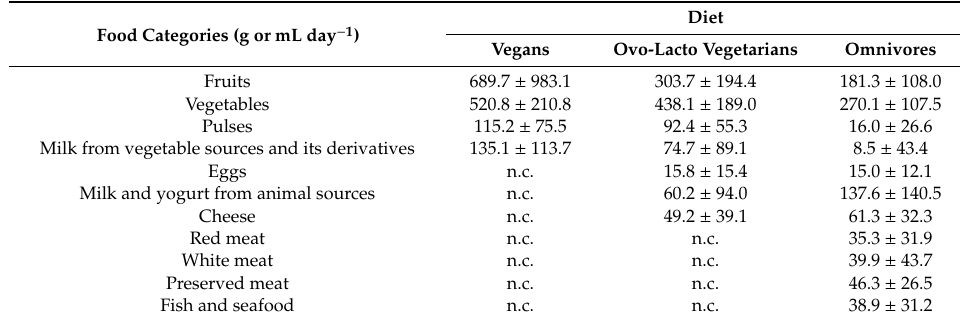
Table 1. The mean quantities (g or mL day − 1 ) of foods with potentially high risk for the introduction of antibiotic resistance (AR) microorganisms and their genes into the human oral cavity regularly consumed by vegans, ovo-lacto vegetarians and